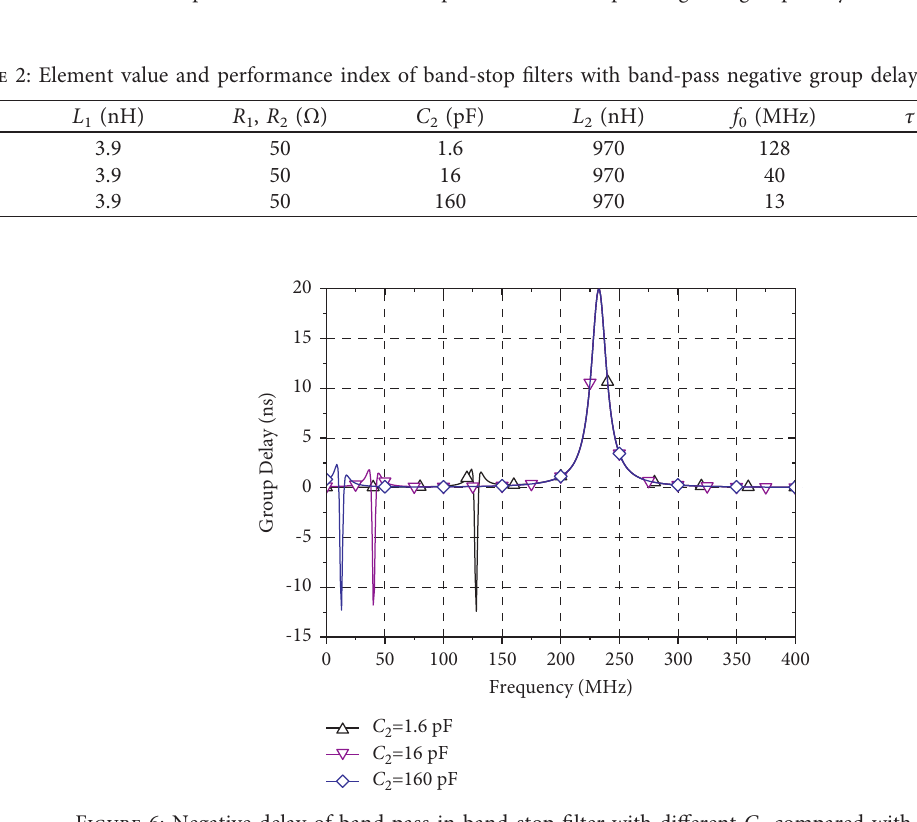
2 compared with Table